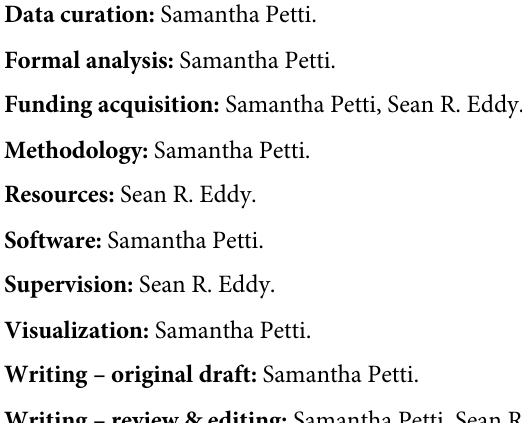
S1 Fig. Characteristics of Pfam seed families successfully split. Each marker represents a family in Pfam. The connectivity of a sequence is the fraction of other sequences in the seed family with at least 25% pairwise identity. Families successfully split into a training set of size at least 10 and a test set of size at least 2 are marked by a cyan circle, whereas families that were not split are marked by a red diamond. In (B) and (D) the cyan circle represents at least one successful split among 40 independent runs. S2 Fig. Size of training and test sets produced by each algorithm on seed families. The two- dimensional normalized histograms illustrate the distribution of training and test set sizes pro- duced by the algorithms among results with at least 10 and 2 training and test sequences respectively. In each plot, the x -coordinate and y -coordinates of the green circle represent the median training and median test set sizes respectively. The white X is placed at the median training and test set sizes among the 2363 families that were successfully split by Blue, Cobalt, and Cluster. S3 Fig. Size of training and test sets produced by each algorithm on full families. The two- dimensional normalized histograms illustrate the distribution of training and test set sizes pro- duced by the algorithms among results with at least 400 and 20 training and test sequences respectively. In each plot, the x -coordinate and y -coordinates of the green circle represent the median training and median test set sizes respectively. The white X is placed at the median training and test set sizes among the 1070 families that were successfully split by Blue, Cobalt, and